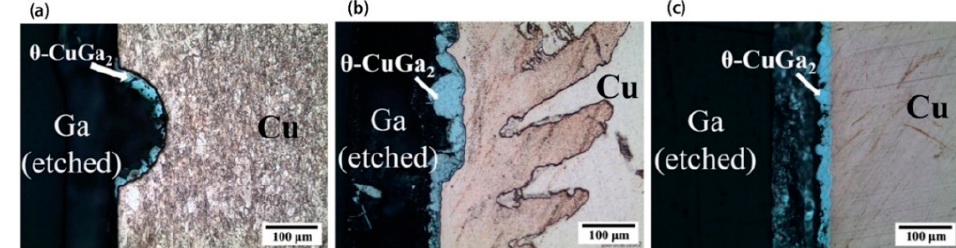
Figure 9. The optical microscope images of ( a ) Ga/polycrystalline-Cu couple reacted at 200 °C for 3 h, ( b ) Ga/single-crystalline-Cu couple reacted at 200 °C for 24 h, and ( c ) Ga/Pt/polycrystalline-Cu couple reacted at 200 °C for 6 h [59].